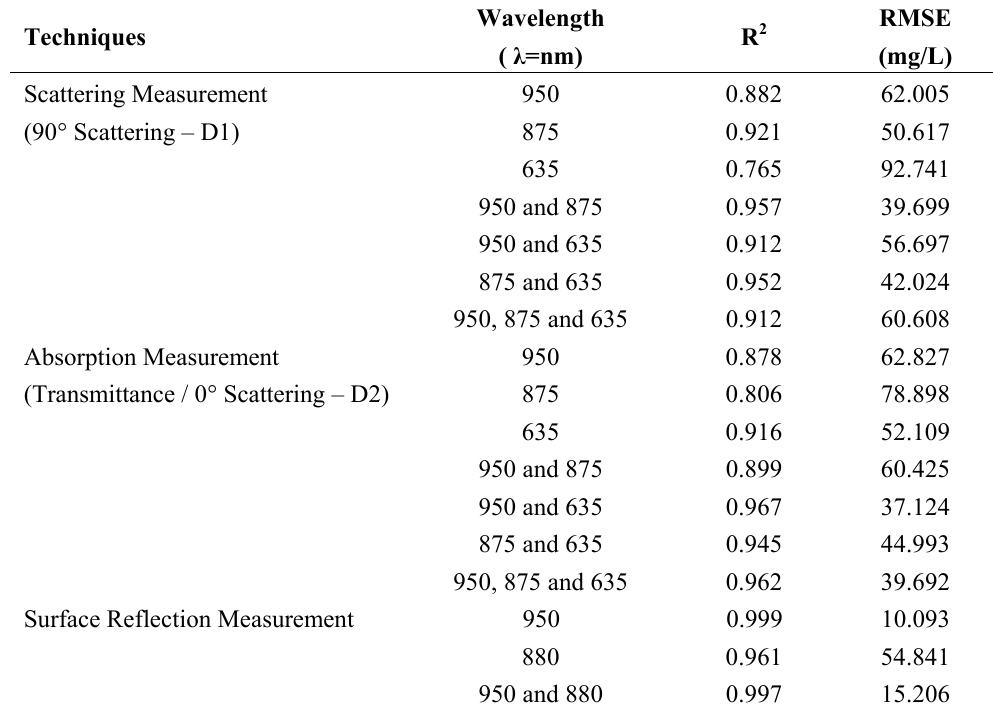
Table 3. Correlation Coefficient (R 2 ) and Root Mean Square Error (RMSE) for the measurement of scattering, absorption and reflected light with different wavelength of light sources